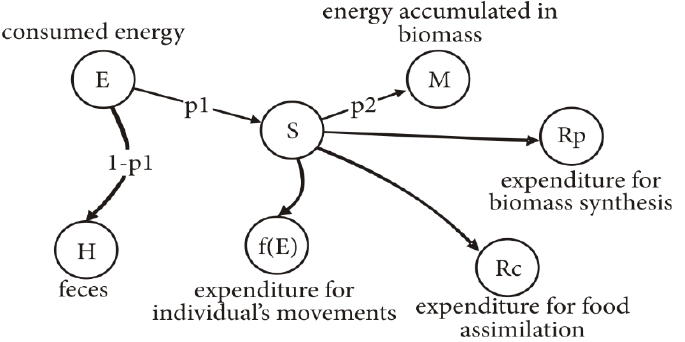
Figure 1. The scheme of distribution of energy E received by a caterpillar when consuming feed.